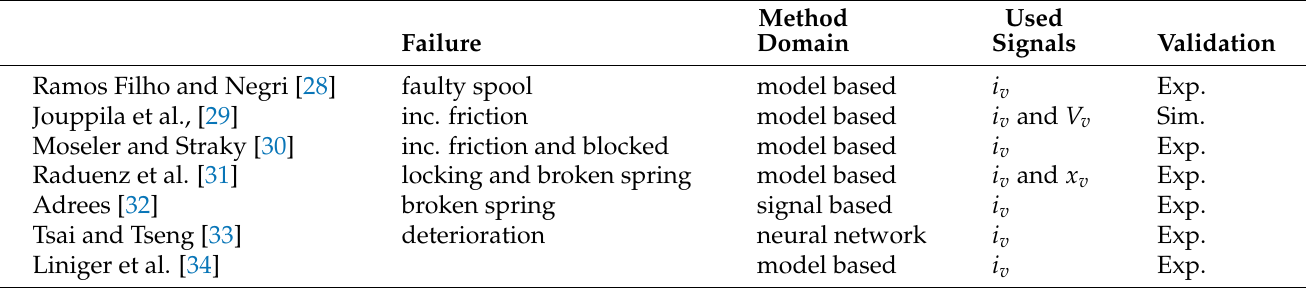
Table 3. Covered fault detection methods for valve failures. i v , V v and x v represent the valve current, voltage and position, respectively.